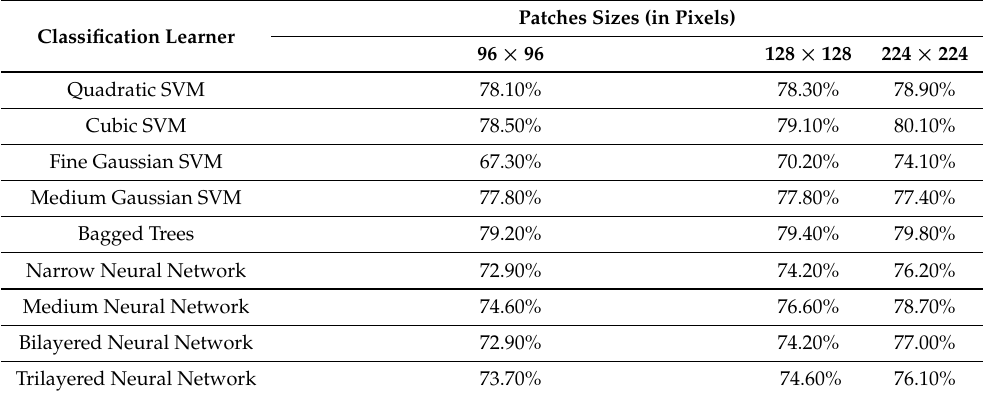
Table 8. Classification result using machine learning